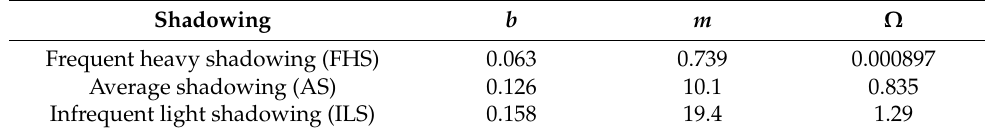
Table 1. Land Mobile Satellite channel parameters. Shadowing b m Ω Frequent heavy shadowing (FHS) 0.063 0.739 0.000897 Average shadowing (AS) 0.126 10.1 0.835 Infrequent light shadowing (ILS)